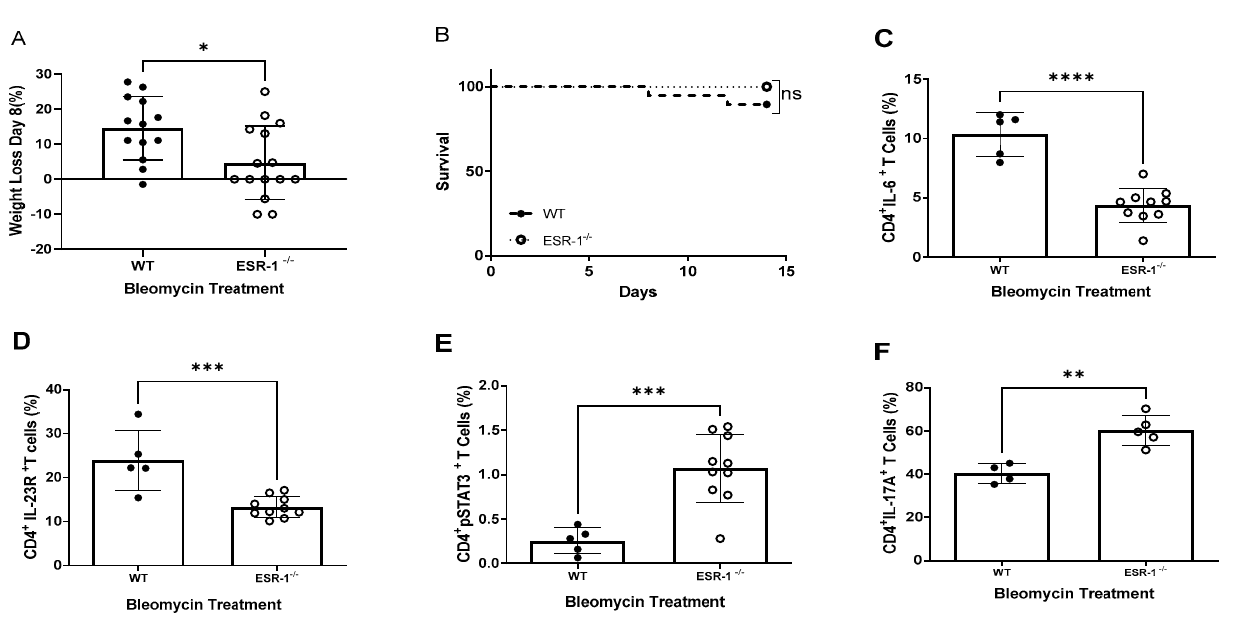
Figure 2. Loss of estrogen receptor alpha subunit (ESR-1) improves survival and ameliorates fi- brosis in female mice . WT and ESR-/- mice were treated with bleomycin and monitored for 14 days. ( A ) Body weights of mice at day 8 compared to day 0; ( B ) Murine mortality across 14 days. Kaplan– Meier survival analysis with a log-rank test was used to determine differences between groups. Flow cytometric analysis of T cells from single-cell lung suspensions at day 14 for ( C ) IL-6, ( D ) IL- 23R, ( E ) pSTAT3Y705 and ( F ) IL-17A. Comparisons between cohorts were performed using one- way ANOVA with Tukey’s post hoc test. * p < 0.05, ** p < 0.01, *** p < 0.001; ns: no significance. Bars are the mean ± SD; each symbol represents an individual mouse. WT: Wild-type, ESR-1-/- estrogen receptor alpha knockout mice. N = 4–15.